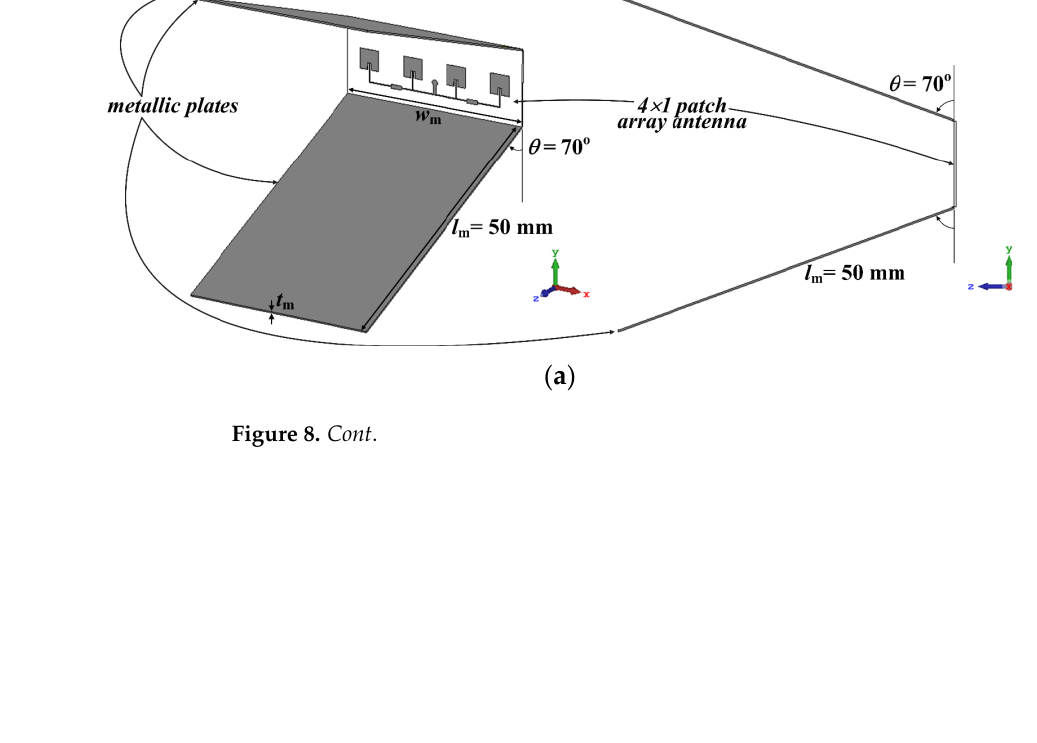
Figure 7. Effects from tilting angle θ of the 4 × 1 array antenna appended with two metallic plates when l m = 10 mm: ( a ) the geometry, ( b ) S 11 , ( c ) the frequencies and magnitudes at the minimum of S 11 , ( d ) realized gain, ( e ) the frequencies and values of maximum gain, ( f ) radiation patterns on the y–z plane for maximum gain frequency, ( g ) radiation patterns on the z–x plane for maximum gain frequency, ( h ) 3D radiation pattern at θ = 30 ° , and ( i ) 3D radiation pattern at θ = 70 ° .